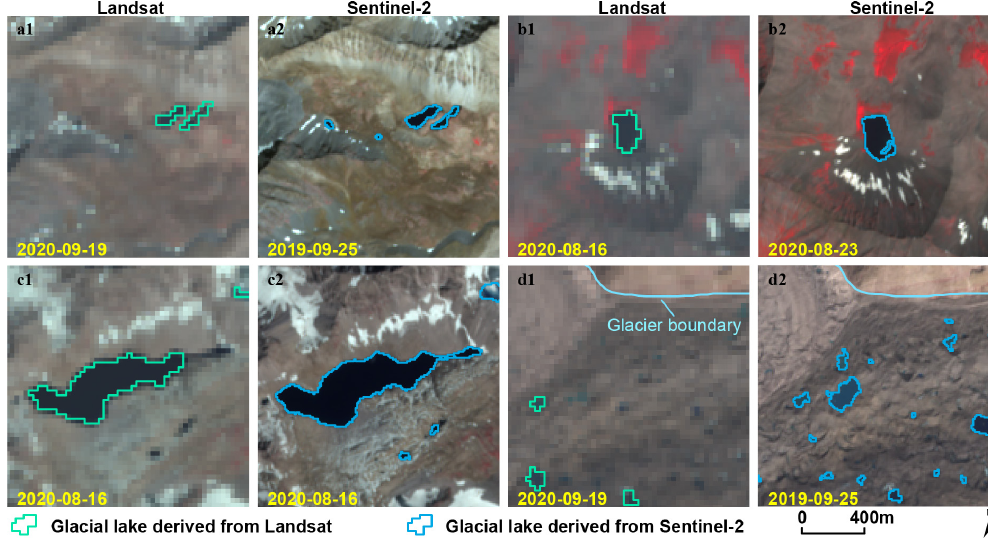
Figure 11. The discrepancy of lake extents extracted from Landsat and Sentinel-2 images. Table 5. Comparison between our Landsat-based mapping and other third-party Landsat-based glacial lake datasets in the study